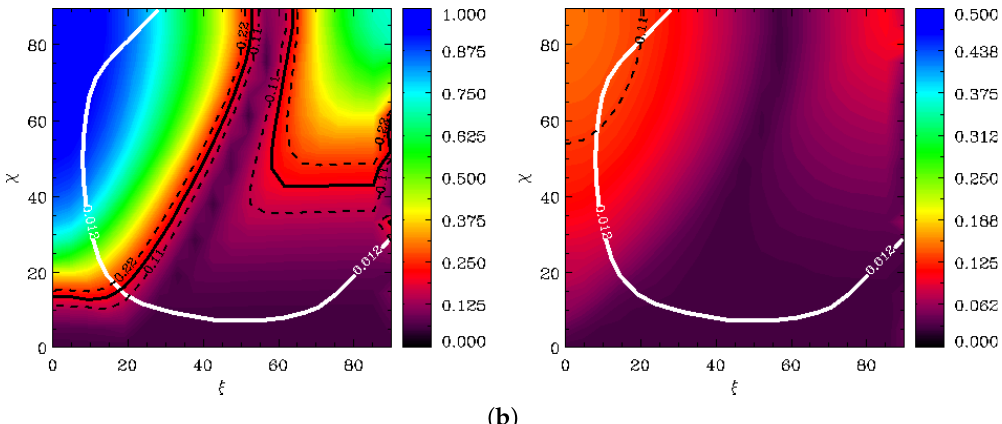
Figure 1. ( a ) Simulation of how the magnetic field affects the light polarization as it propagates away from the neutron star, as predicted by the vacuum birefringence effect. In this case, a distance up to nine neutron star radii has been considered. The blue and red arrows indicate the electric and magnetic field vectors, respectively (image credit ESO). As can be seen, the vector orientation changes with the distance from the neutron star surface, and so does the light polarization. ( b ) Simulated PD of RX J1856.5 − 3754 (in color scale) as a function of the angles χ and ξ , i.e., between the line of sight and the isolated neutron star (INS) spin axis and between the INS magnetic and spin axis, respectively. A black body emission model is assumed in the case shown here. The white solid line represents the constraints on χ and ξ inferred from the pulsed X-ray light curve (see [35] for details), whereas the black solid line corresponds to the VLT optical polarization measurement [35], including 1 σ errors (black dashed line). The plots on the left and on the right represent the cases when QED effects are and are not accounted for, respectively (adapted from